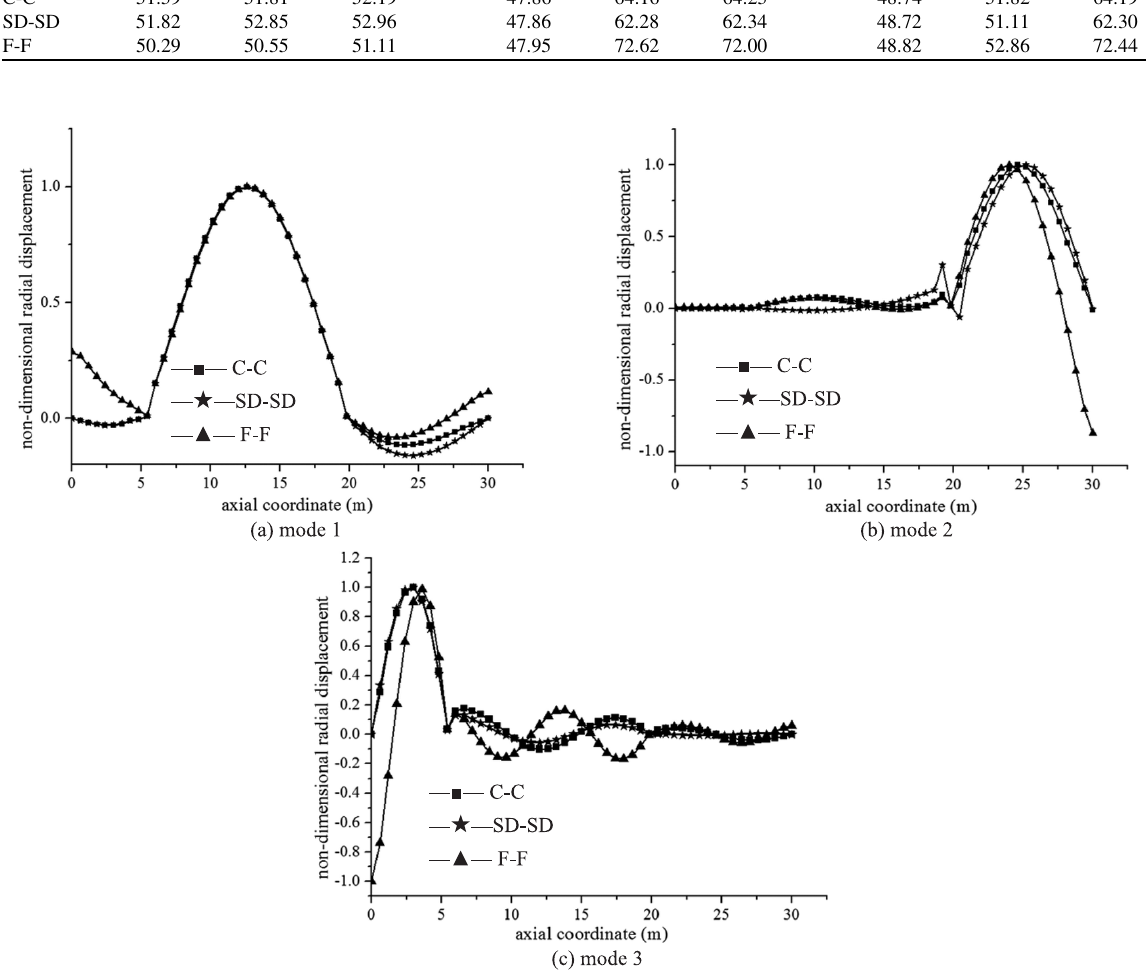
Fig. 18. Vibration mode shapes of model M6 when n = 4 with different boundary